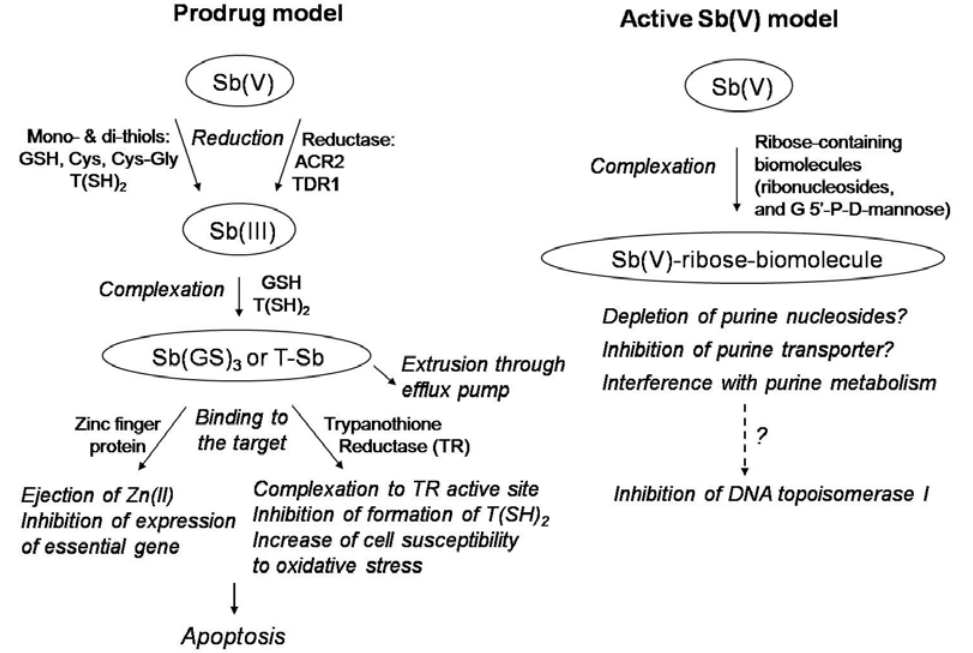
Figure 2. Two main models proposed for the mechanism of action of pentavalent antimonials against leishmaniasis. According to the “Prodrug model”, Sb(V) is reduced to Sb(III) in order to exert antileishmanial activity. According to the “Active Sb(V) model”, Sb(V) exhibits intrinsic antileishmanial